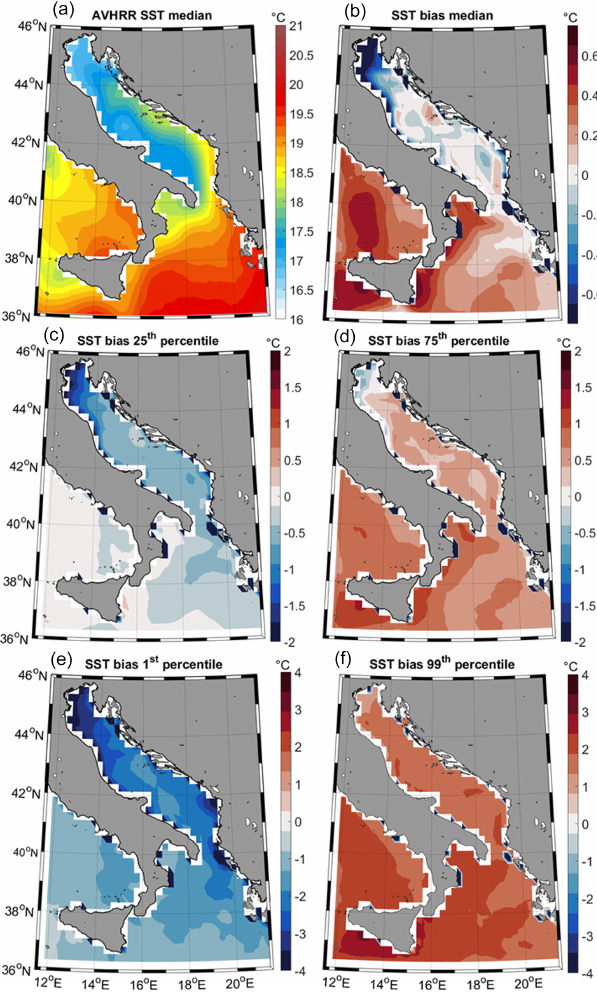
Figure 5. As in Fig. 4 but for the JPL MUR daily sea surface tem- perature product during the 2002–2017